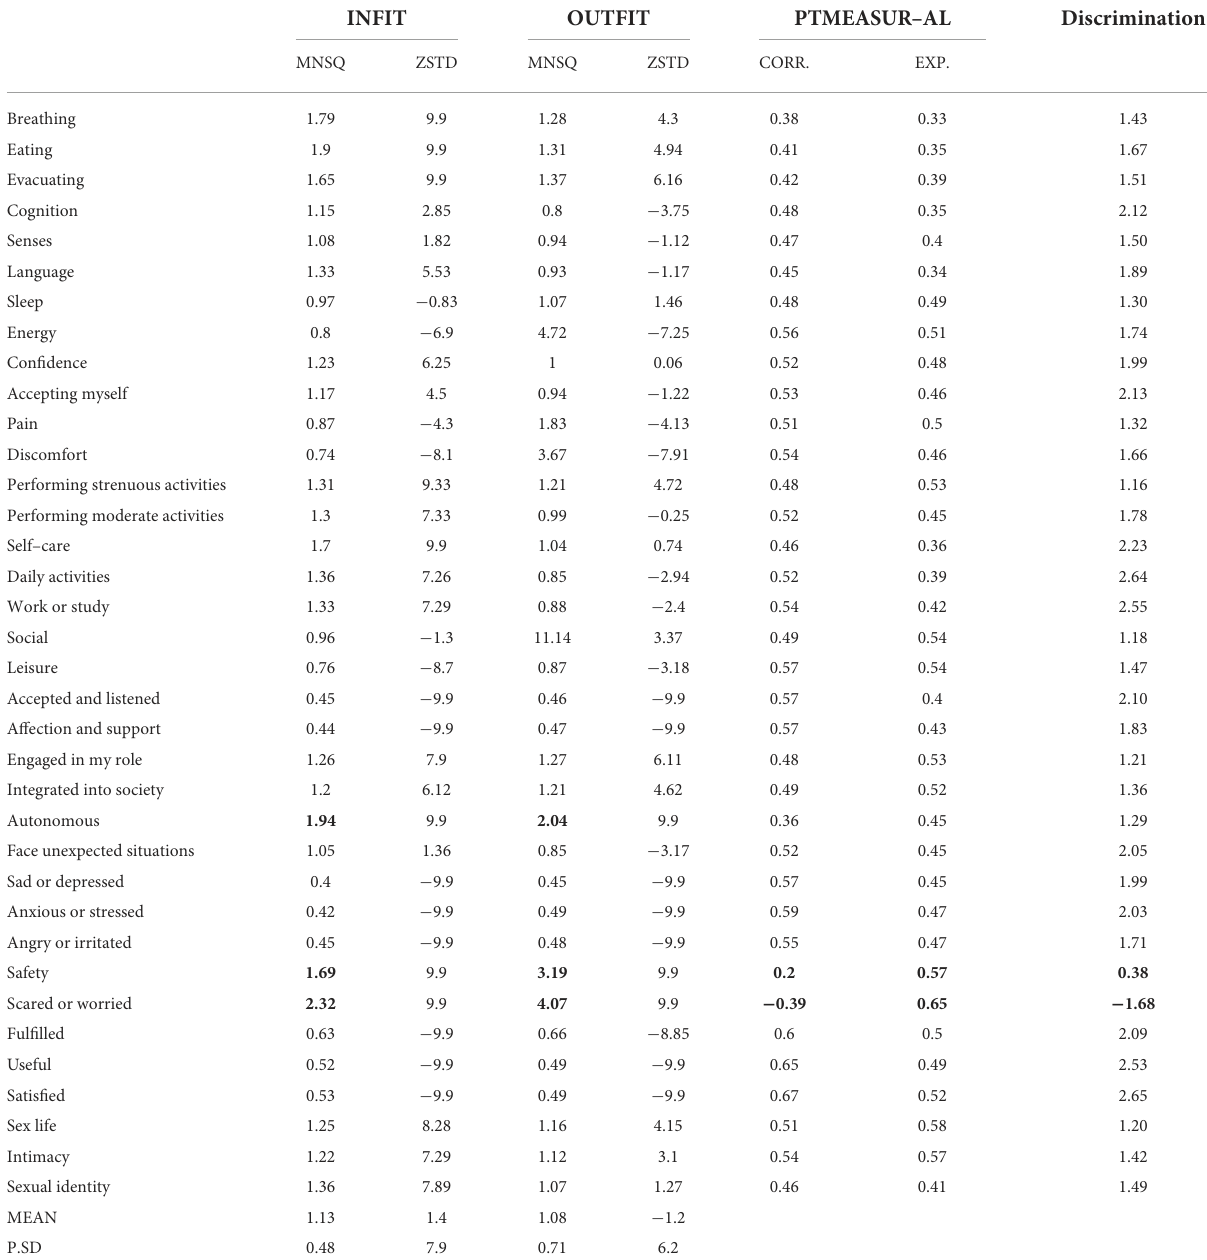
TABLE 9 Rasch analysis results.